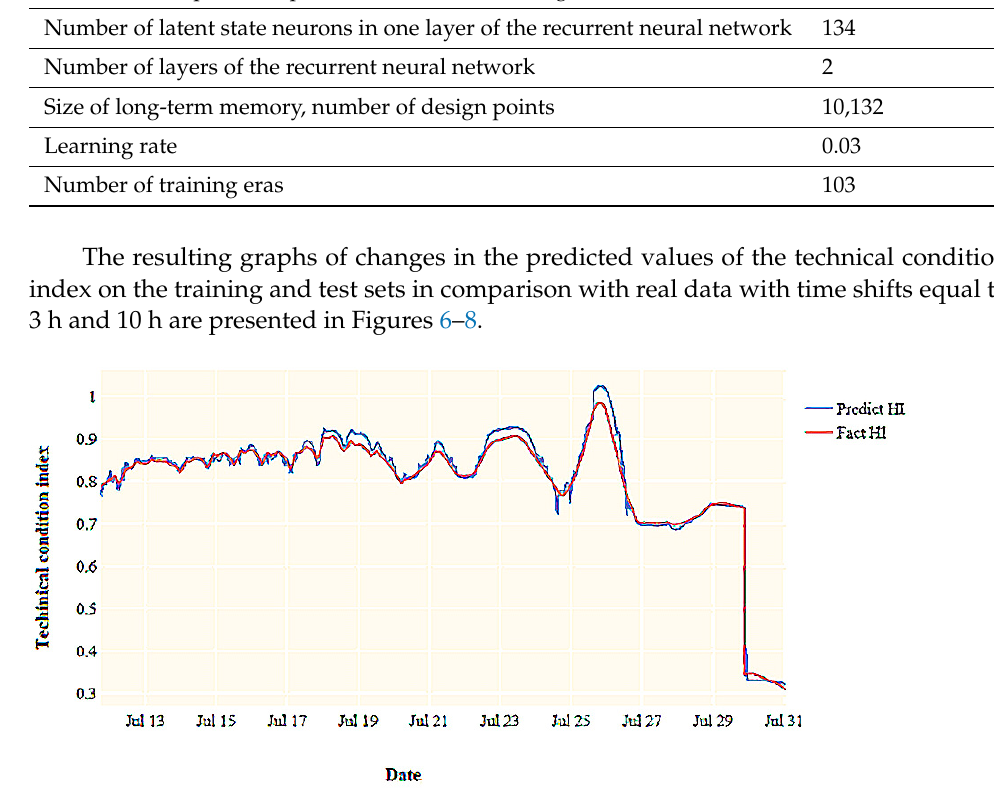
Figure 8. Changes in the predicted values of the technical condition index on the test set in com- parison with real data (time shift—10 h). With increasing training eras, the calculated value of the error on the training set decreases and takes on a constant value during subsequent iterations of gradient descent and updating the weight coefficients. In this case, the value of the error on the validation set is stochastically decreasing. This behavior of the error on the validation set relative to the error functional on the training set indicates that the tuned LSTM model of the recur- rent neural network did not overfit at the specified training interval. The change in the technical condition index on the training sample with a time offset of 3 h shows that the model quite accurately repeats the real behavior of this index ( √ MSD = 0.011). However, it is worth noting that due to the existing time offset (the time lag of the data entering the model input), it is possible to observe “run-outs” in the predicted values of the technical condition index relative to the real ones. These “run-outs” can help to accurately determine the time of equipment failure when they are correctly compared with the probability that the current technical condition of the equipment belongs to a defect.